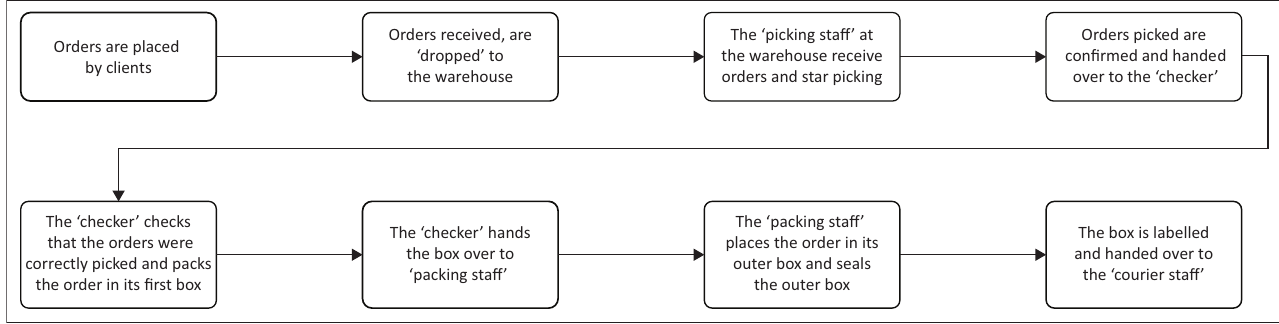
Orders are placed by clients